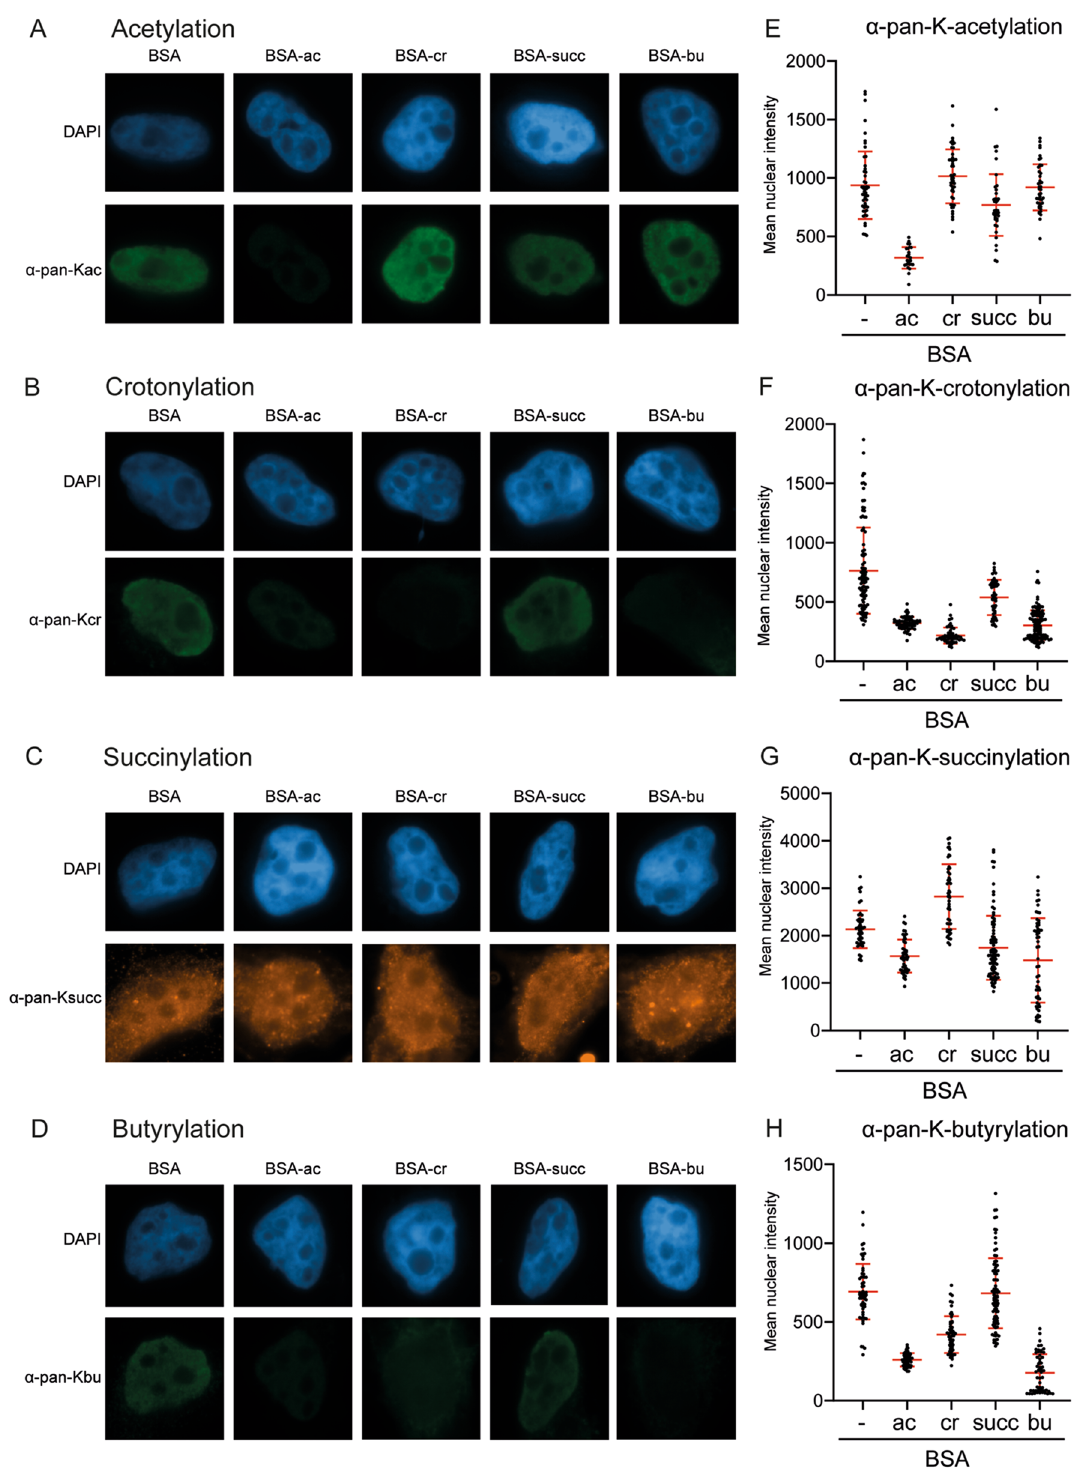
Figure 4. Immunofluorescence assays using pan-K-acyl antibodies with BSA competitors on HeLa cells. ( A ) Representative immunofluorescence images of HeLa cells showing nuclei stained with DAPI and pan-K-acetyl- recognizing antibodies against ( A ) acetylation, ( B ) crotonylation, ( C ) succinylation or ( D ) butyrylation in the presence of the indicated BSA competitors. ( E – H ) Quantification of data, representing the mean intensity of individual nuclei from ( A – D ), respectively. For each microliter of antibody, one microgram of BSA was added as